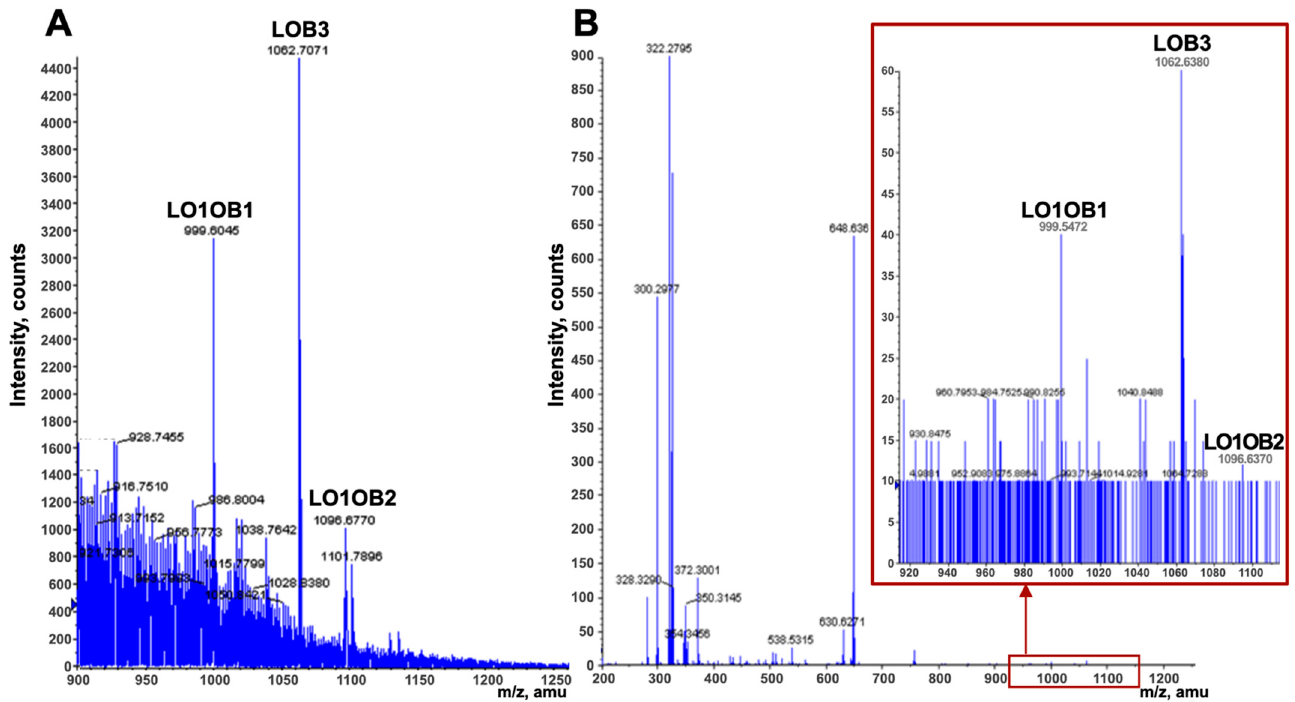
Figure 2. Localization of observed LOs (LO1OB1, LO1OB2, and LOB3) in ( A ) pig and ( B ) rainbow trout adipose, identified via direct injection on an Agilent 1100-series HPLC-ToF-MS. trout adipose, identified via direct injection on an Agilent 1100-series